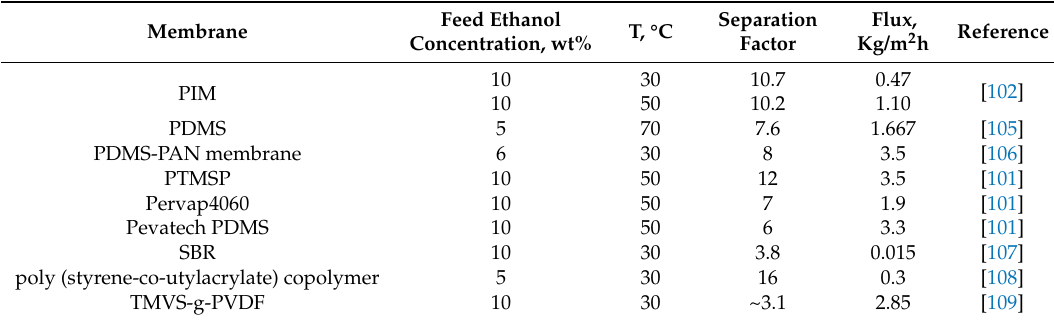
Table 2. Comparisons of the separation performance for the pervaporative separation of ethanol-water solution for different polymer